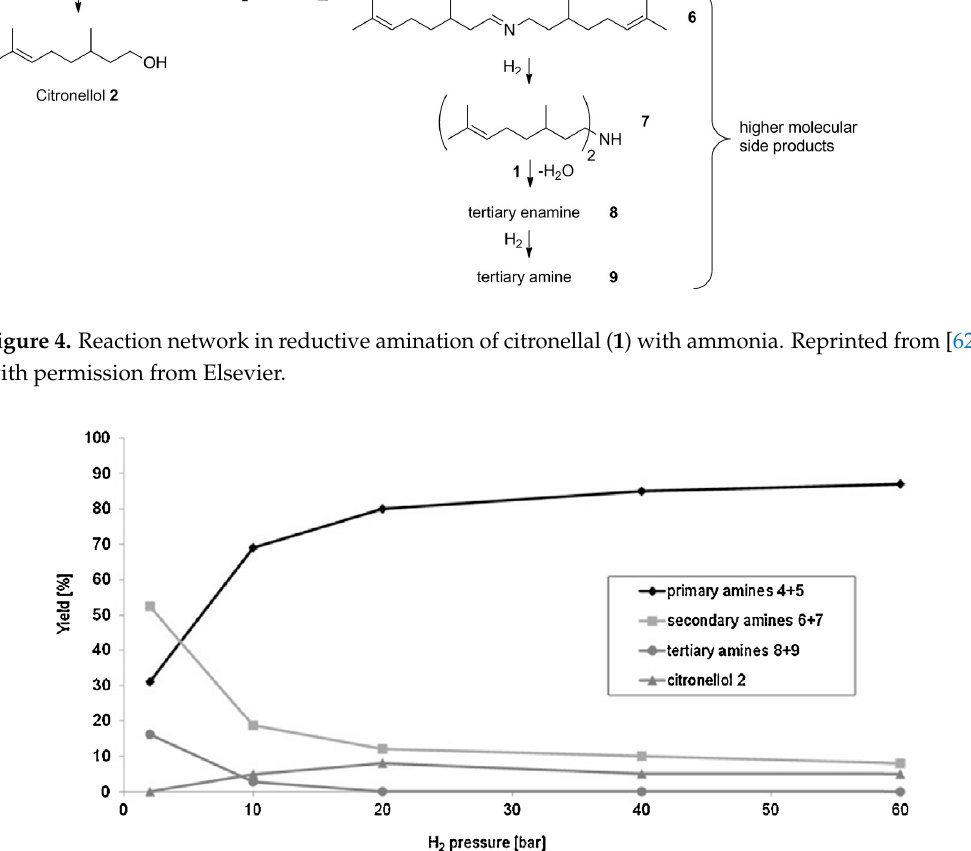
Figure 5. Influence of hydrogen pressure on the product distribution in the reductive amination of citronellal; data points are connected to show a better comparison. Reaction conditions: 6 mmol citronellal ( 1 ), 216 mmol NH 3 , 0.5 mol% [Rh(cod)Cl] 2 , 2.0 mol% TPPTS, 0.5 mol% CTAC, 5 mL toluene, 130 ◦ C, 800 rpm, 6 h. Reprinted from [62] with permission from Elsevier.